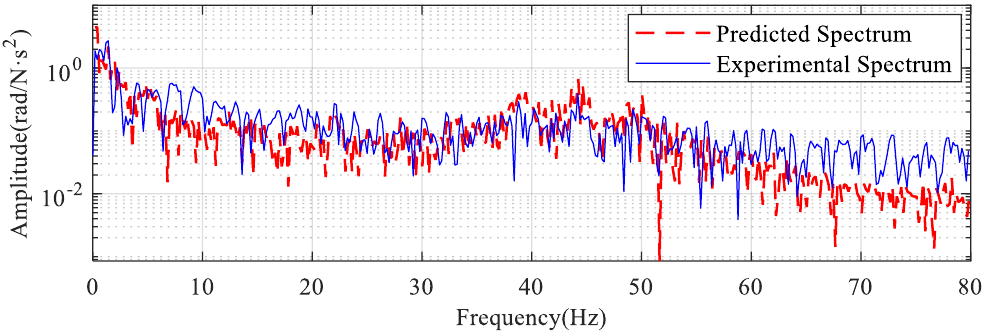
Figure 15. Comparison of predicted spectrum and experimental spectrum.